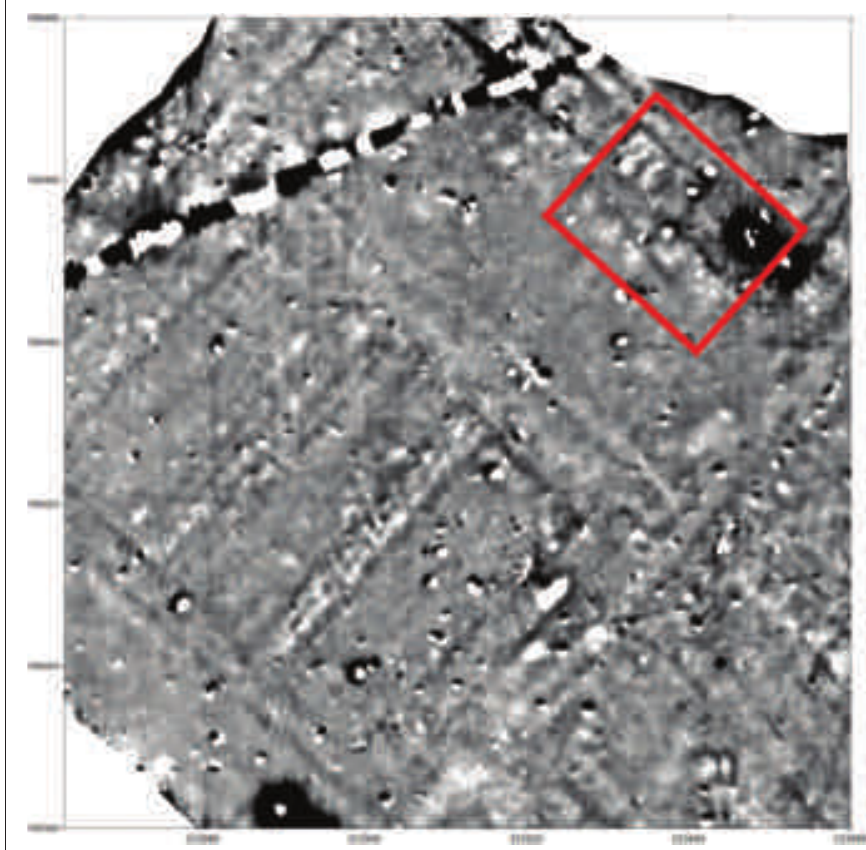
Figure 2 Detailed magnetometry of the Priory Field, with the excavation trench